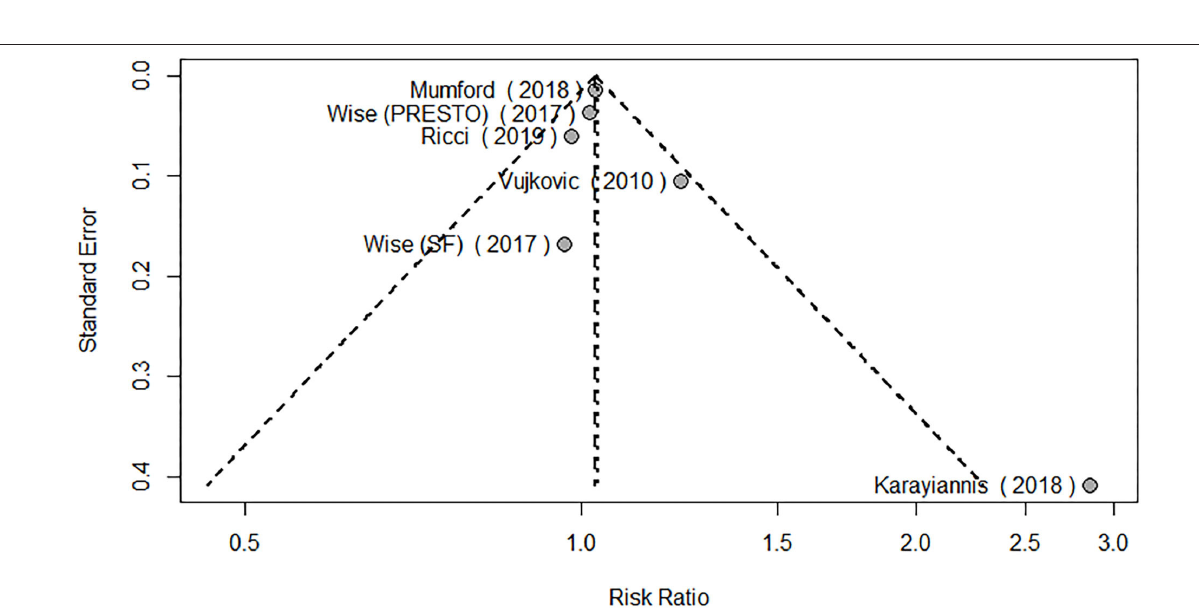
FIGURE 7 | Funnel plot of the eligible MUFA